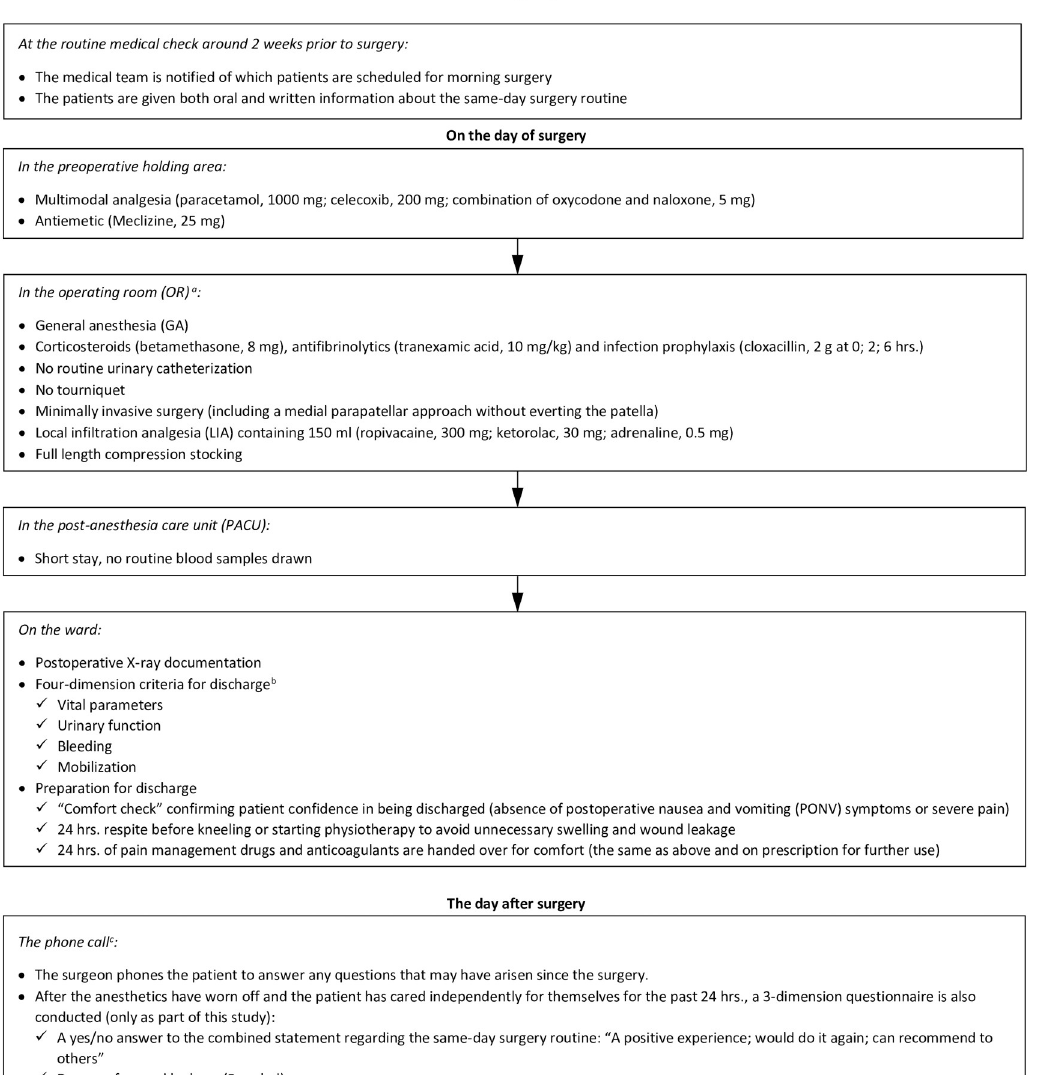
The 3-month follow-up ended with a doctor’s appointment confirming little to no discom- fort, no need of crutches, and a clinically well-balanced knee with full range of motion (other- wise action taken). The proportion of SDD achievements and any additional resources relocated to the outpatient department, up to or initiated at either of the two-week nurse/PT